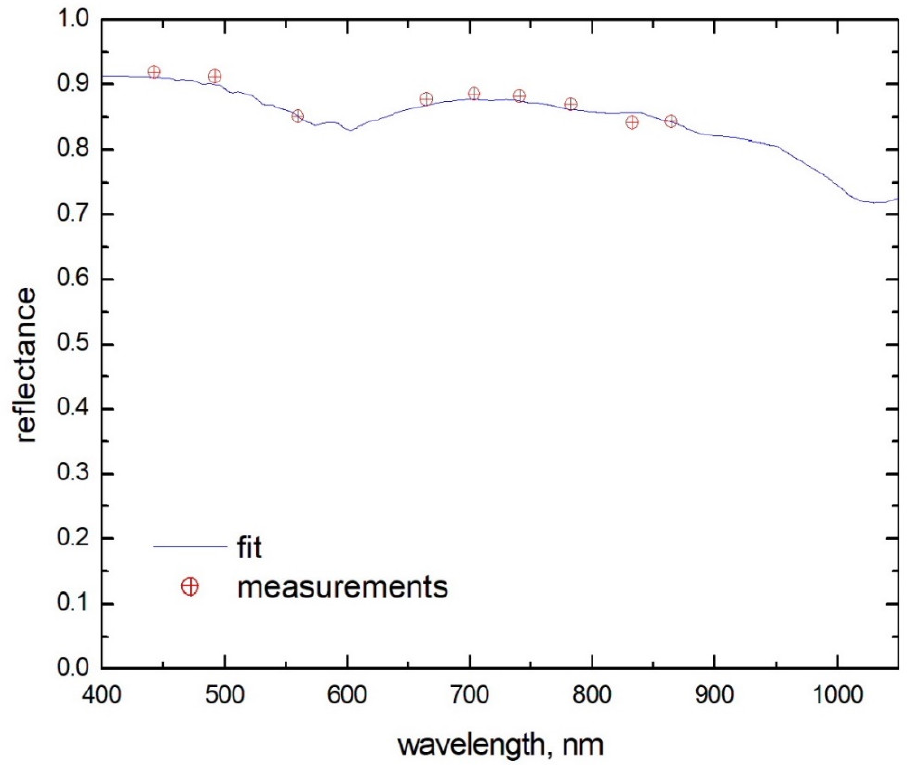
Figure 1. The fit of MSI spectral reflectance over Dome C (Antarctica) (see Equation (4)). The MSI/ S-2 TOA reflectance observations were performed on 3 November 2020 during the ozone hole occurrence [26]. The retrieved values of the parameters given in Equation (4) for the case shown in Figure 1 are: K = 1.66 19 10 2 / cm molecule and L = 2.13 mm. They were derived using Equation (5) and data are given in Table 2. Table 2. The parameters used in Equation (5).